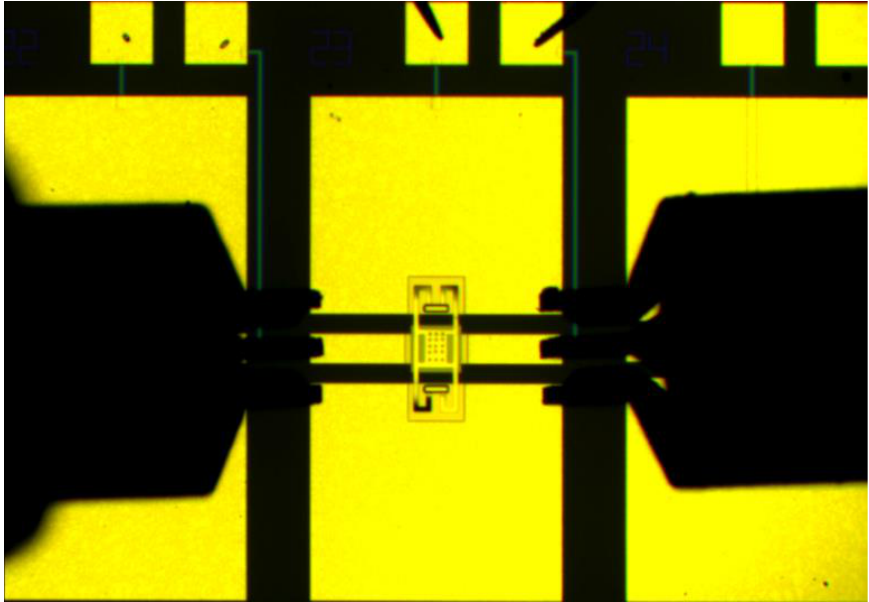
Figure 13. The top view photograph of the proposed RF MEMS switch.